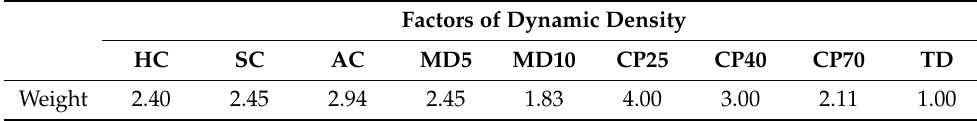
Table 1. The subjective weight of each factor of dynamic density.